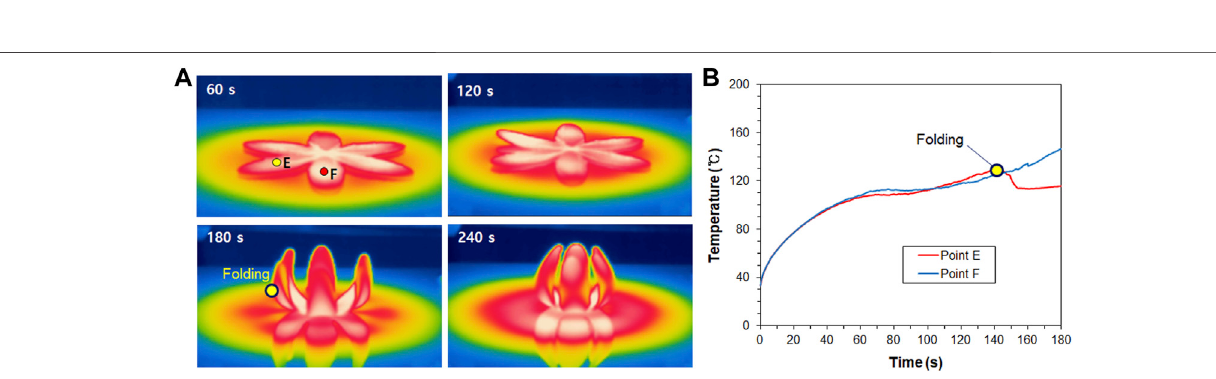
Frontiers in Materials |